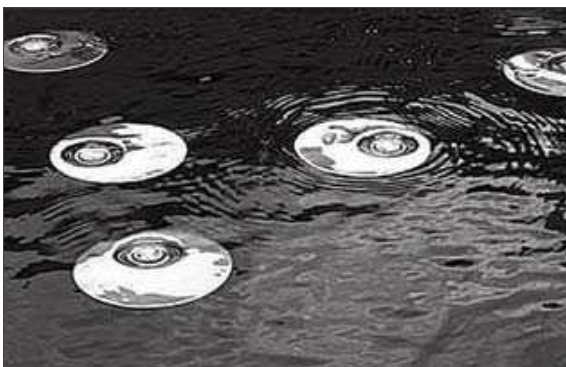
Fig. 22. Lights “Metal water lilies”, 2009. architects